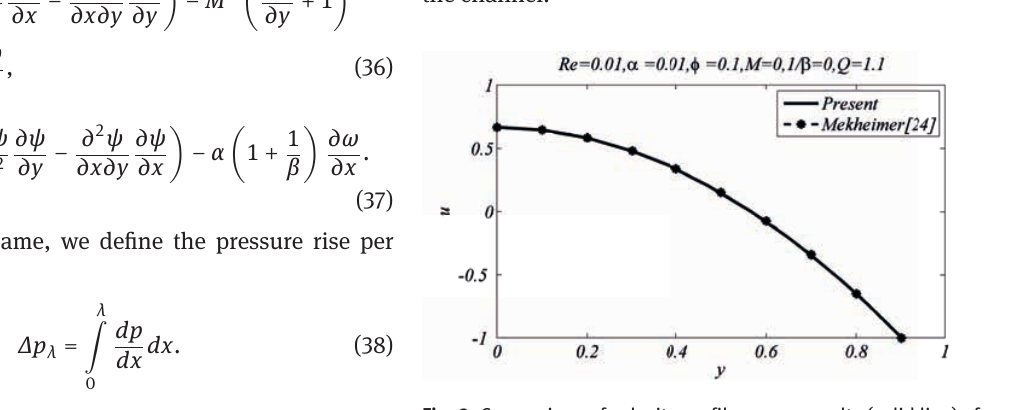
Fig. 2: Comparison of velocity profile on our results (solid line) of a sinusoidal wave with Mekheimer [24].